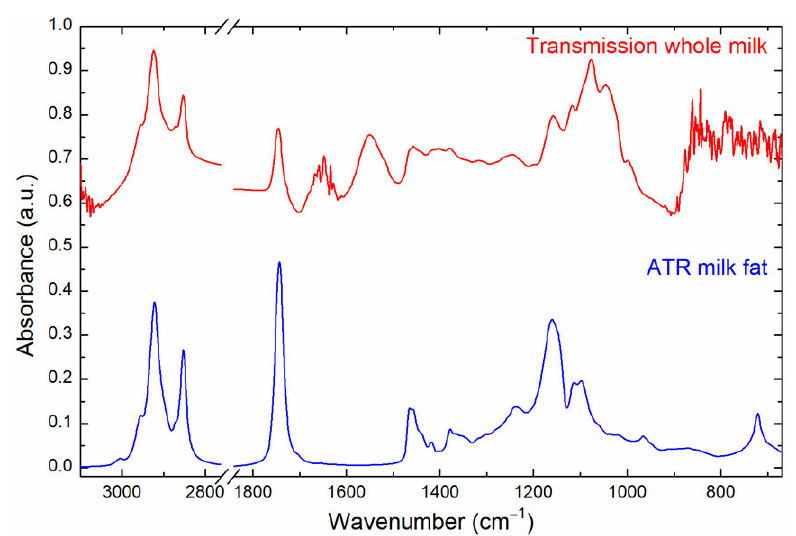
Figure 1. Comparison between the ATR-IR absorbance spectrum of separated milk fat (blue) and whole milk recorded in transmission mode with a CaF 2 cell with an optical path length of 37 µ m (red). The spectral range between 1850 and 2750 cm − 1 was removed due to lack of relevant